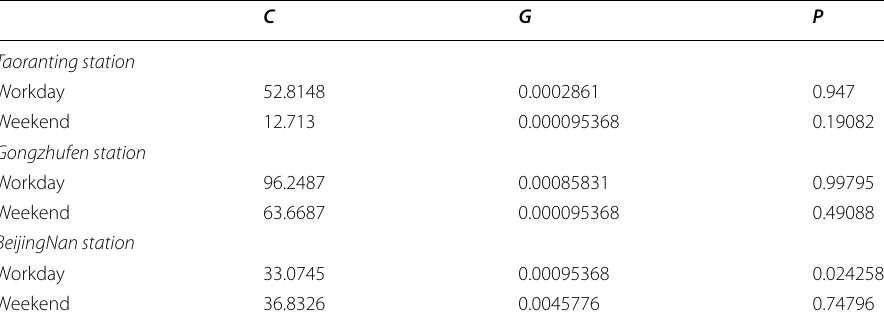
Table 2 Parameter of